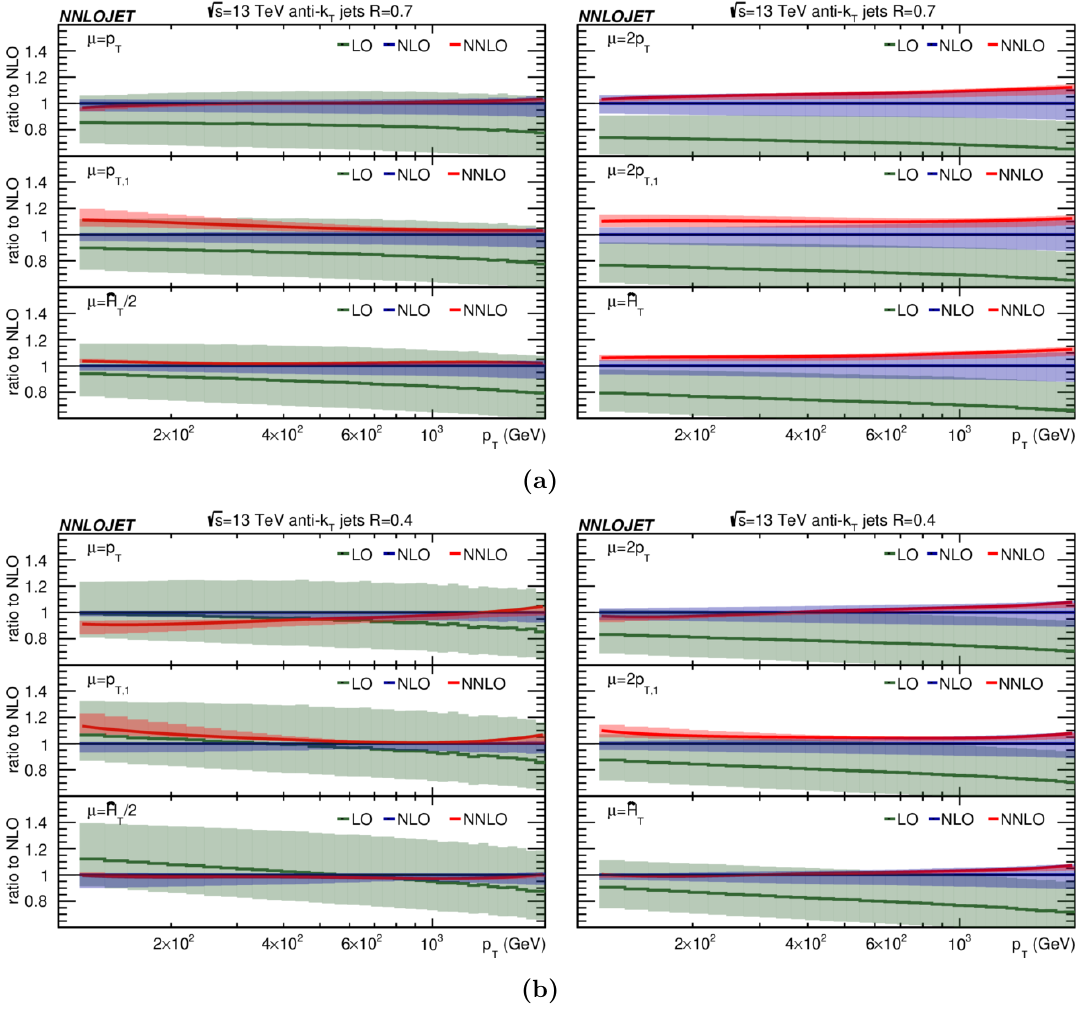
Figure 14 . Inclusive jet p T spectrum integrated over rapidity at LO (green), NLO (blue) and NNLO (red) normalised to the NLO prediction as a function of the central scale choice for (a) cone size R = 0 : 7 and (b) cone size R = 0 :